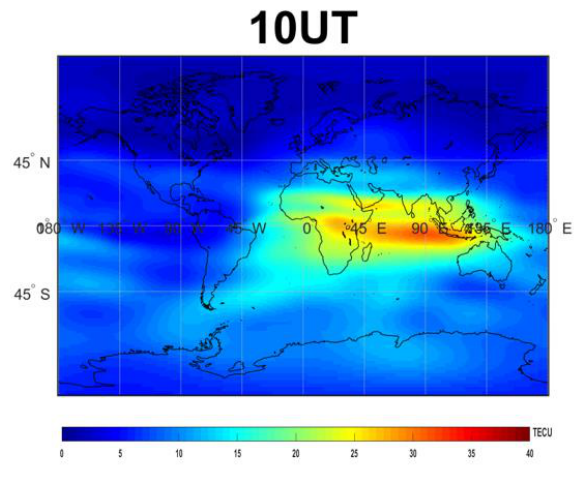
Figure 2 . VTEC-Map at UT = 10 on 1 st January 2018.